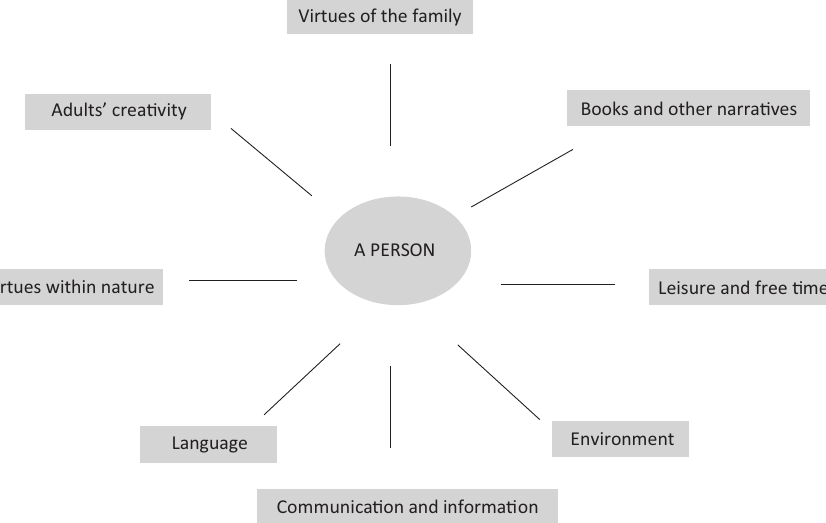
Figure 1. Factors influencing the creativity (source: created by